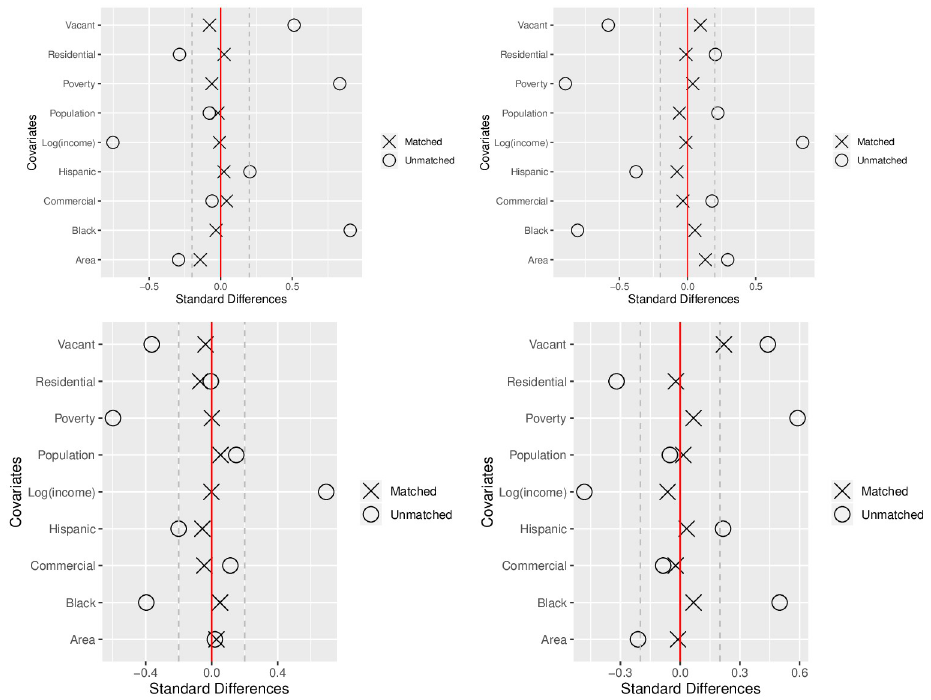
Fig 3. Top row is the standardized differences between neighborhoods with high vs. low community vibrancy, both before and after propensity score matching. Top Left : total number of permits as the measure used to define the high vs. low community vibrancy group. Top Right : spontaneous proportion as the high vs. low community vibrancy measure. Bottow row is the standardized differences between neighborhoods with increasing trends over time in community vibrancy or not. Bottom Left : treatment group is neighborhoods that have a significantly increasing trend over time in block party permits. Bottom Right : treatment group is neighborhoods that have a significantly increasing trend over time in spontaneous